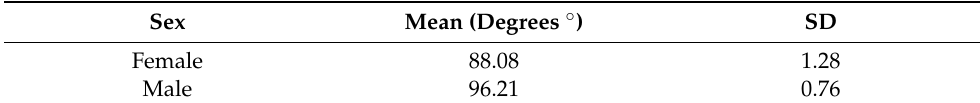
Table 2. Evaluation of range of motion (ROM) with different weights by gender.